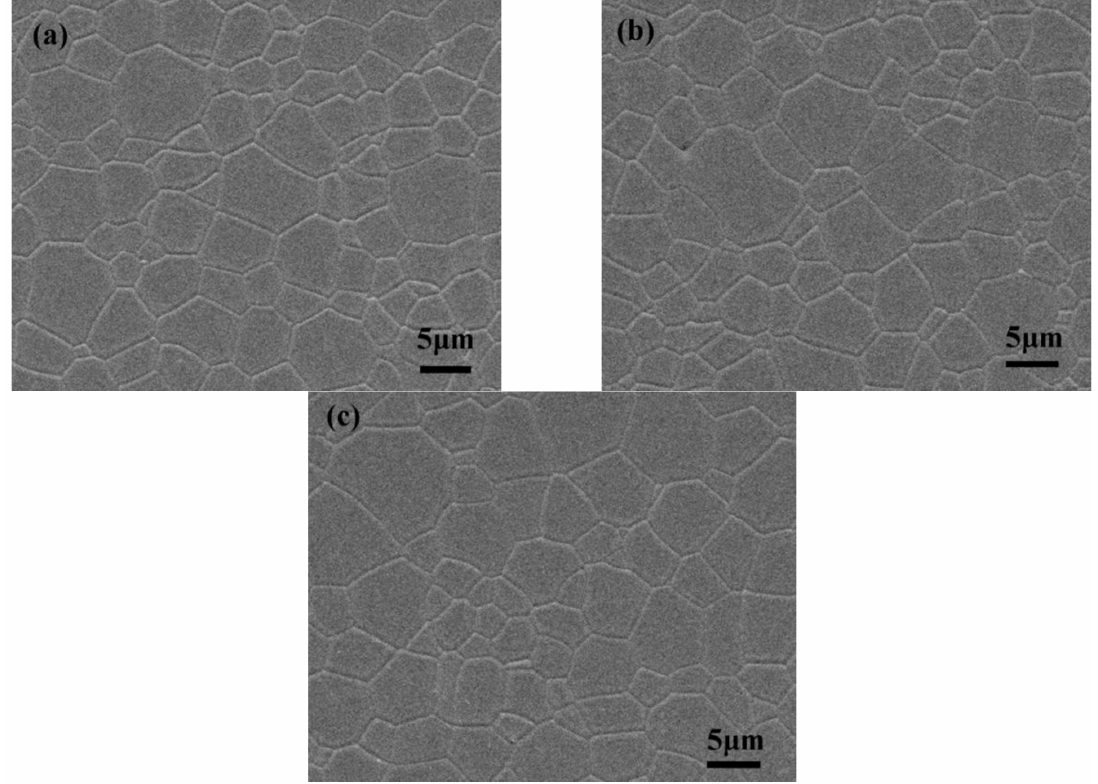
Figure 6. Thermally etched surface morphologies of (Y 1 − x Yb x )AG transparent ceramics sintered at 1700 ◦ C, ( a ) x = 0, ( b ) x = 0.01, ( c ) x =